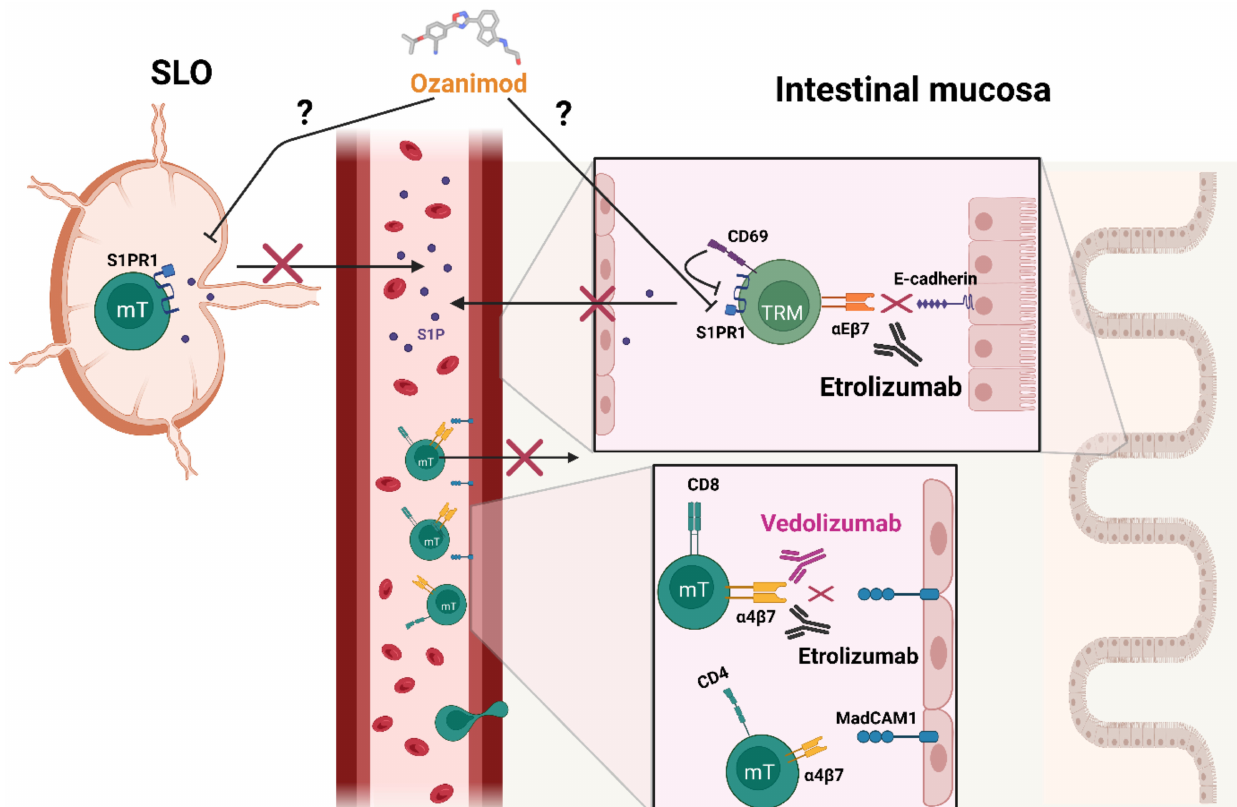
Figure 2. Possible effects of various drugs on mT cells. Vedolizumab can block the α 4 β 7 integrin and can therefore inhibit the migration of T cells from the bloodstream into the intestinal mucosa, ameliorating inflammation. Etrolizumab acts not only on the α 4 β 7 integrin but also interferes with the α E β 7:E-cadherin interaction, possibly impairing the tissue retention of TRMs. Ozanimod targets S1PR1 receptors and might therefore anticipate the egress of mT from lymph nodes into the circulation but might also contribute to and synergize the CD69-mediated tissue retention in the